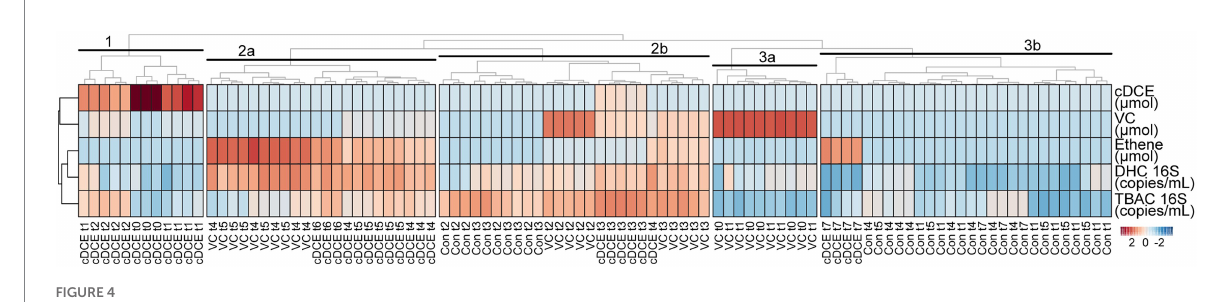
FIGURE 4 Correlation heatmap of metadata. Abbrev: DHC: Dehalococcoides , TBAC: total bacteria, cDCE: cis -dichloroethene, VC: vinyl chloride.